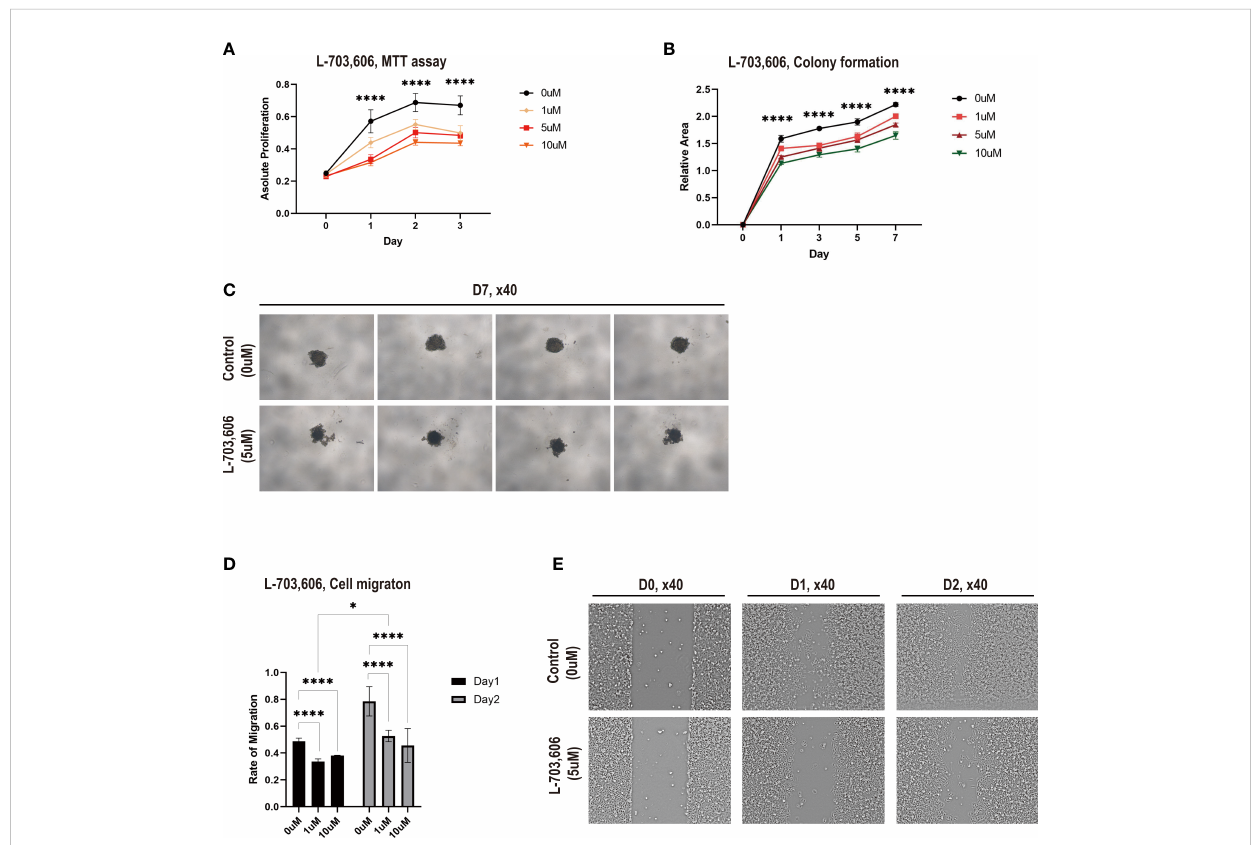
FIGURE 6 Na+ leak channel, non-selective (NALCN) inhibition suppresses lung cancer cell proliferation and migration. (A) Cell proliferation was detected by MTT assay following L-703,606 treatment of A549 cells. The experiment was repeated 3 times. (B) Colony formation of A549 cells treated with L- 703,606. The experiment was repeated 2 times. (C) Representative images of the colony formation assay. The experiment was repeated 3 times. (D) Wound healing assay of A549 cells treated with L-703,606. (E) Representative images of the wound healing assay. **** and * represent the difference is signi fi cant at a signi fi cance level of